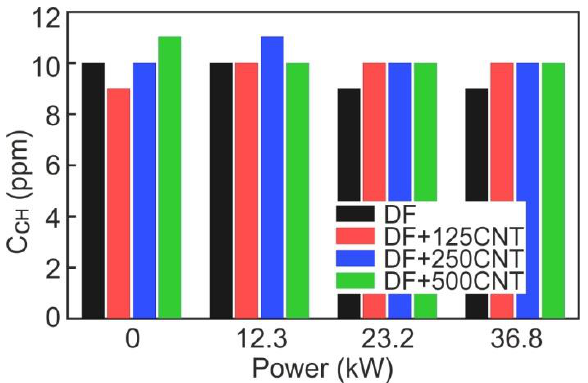
Figure 8. Change in hydrocarbon ( C HC ) in exhaust gas depending on the amount of CNT addition at different diesel engine loads.